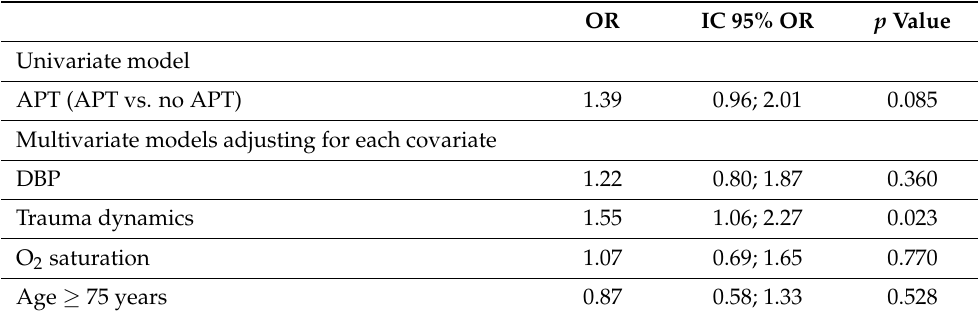
Table 6. Logistic regression model for the for the association between treatment (APT vs. no APT) and bleeding